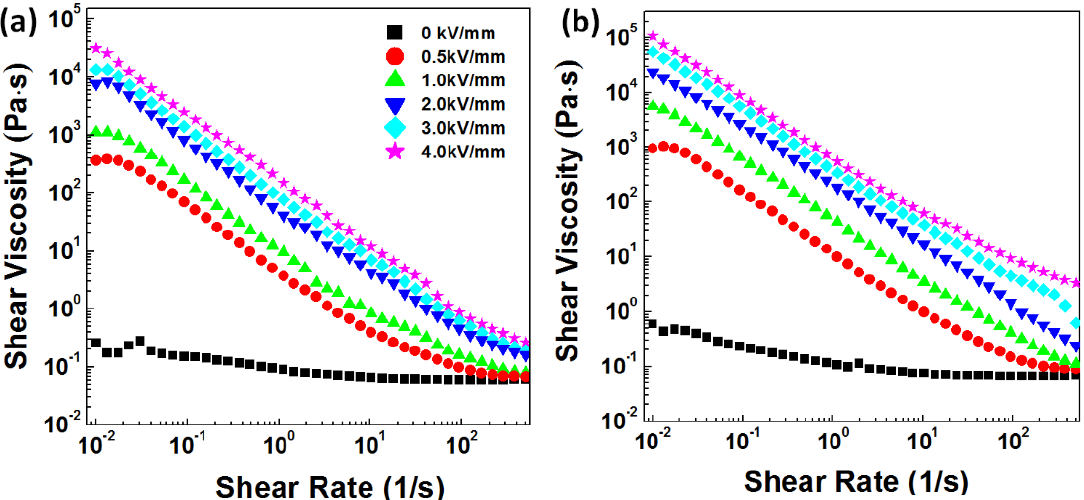
Figure 6. Shear viscosity vs. shear rate at different electric field strengths for the ER fluids of pristine cellulose ( a ) and Cel-Si-Urea ( b ).